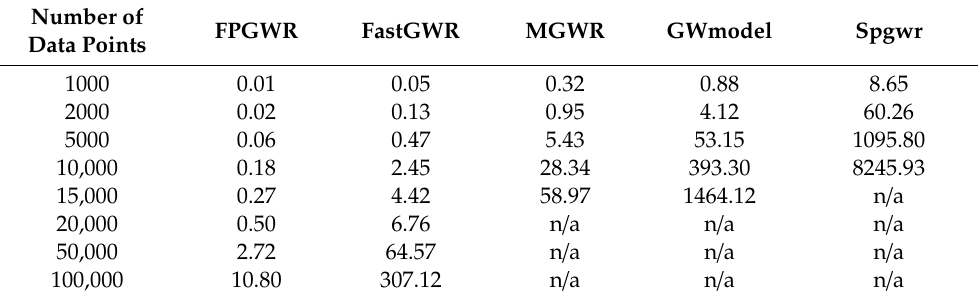
Table 4. Runtime (in seconds) for five GWR packages using di ff erent numbers of data points.